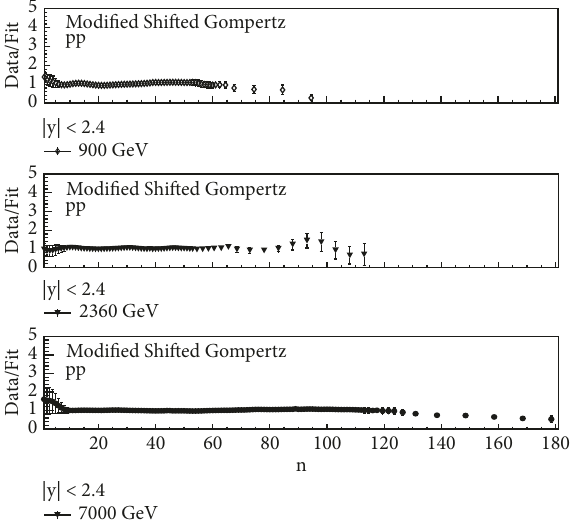
Figure 8: ratio plots of data versus modified shifted Gompertz fit values for the 𝑝𝑝 collisions in full phase space.